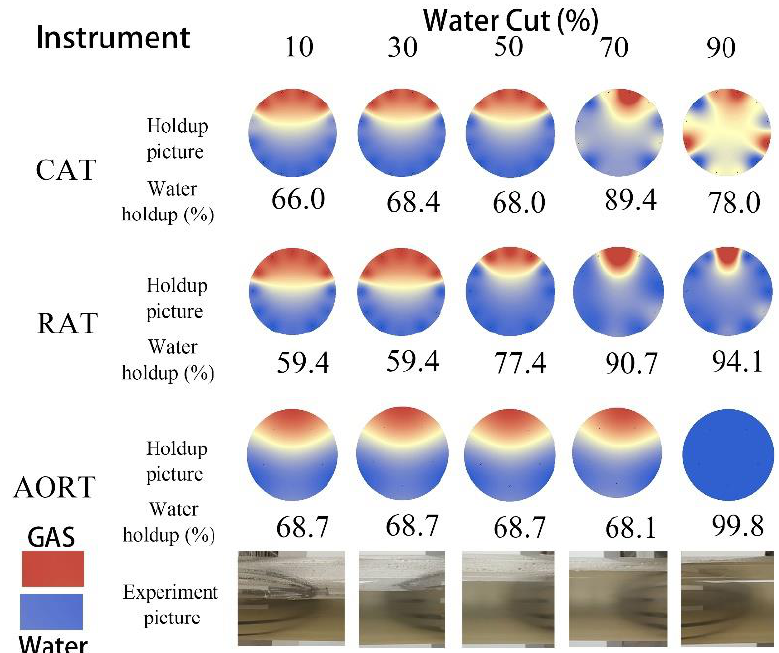
Figure 7. Comparison of interpolation imaging under different water cut conditions of 300 m 3 /d of gas and water.